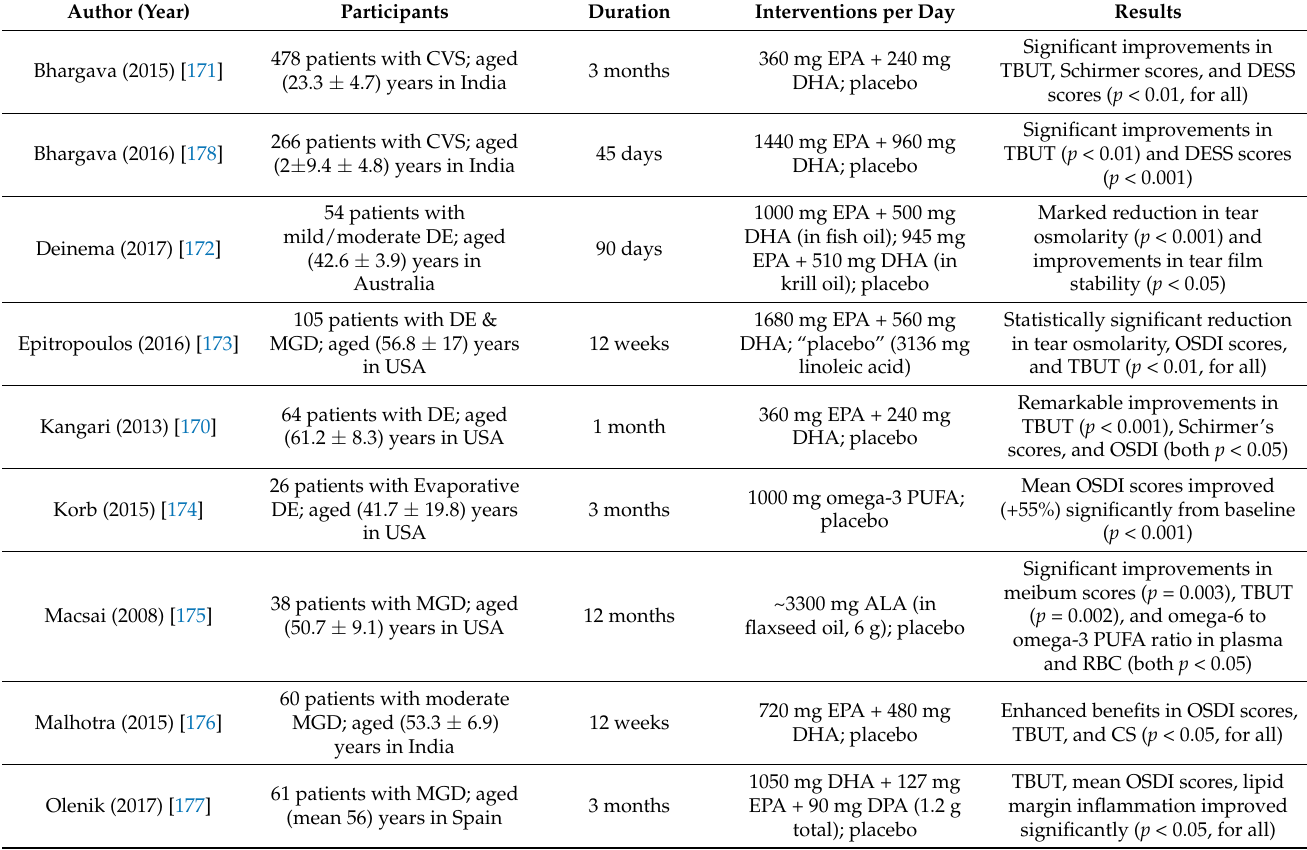
Table 1. Characteristics of the randomized clinical trials using omega-3